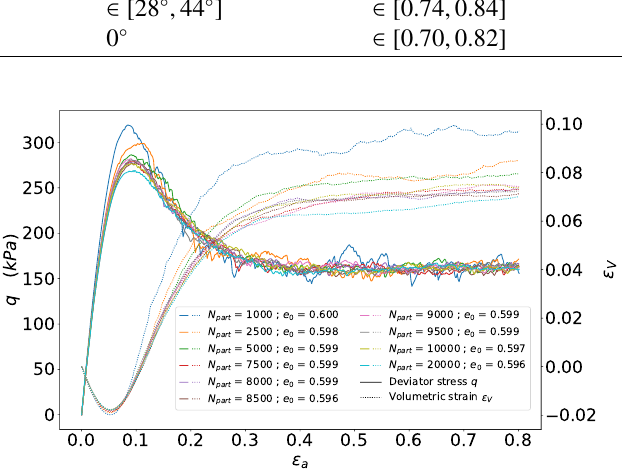
Figure 2. q and (cid:15) V during some S1 simulations